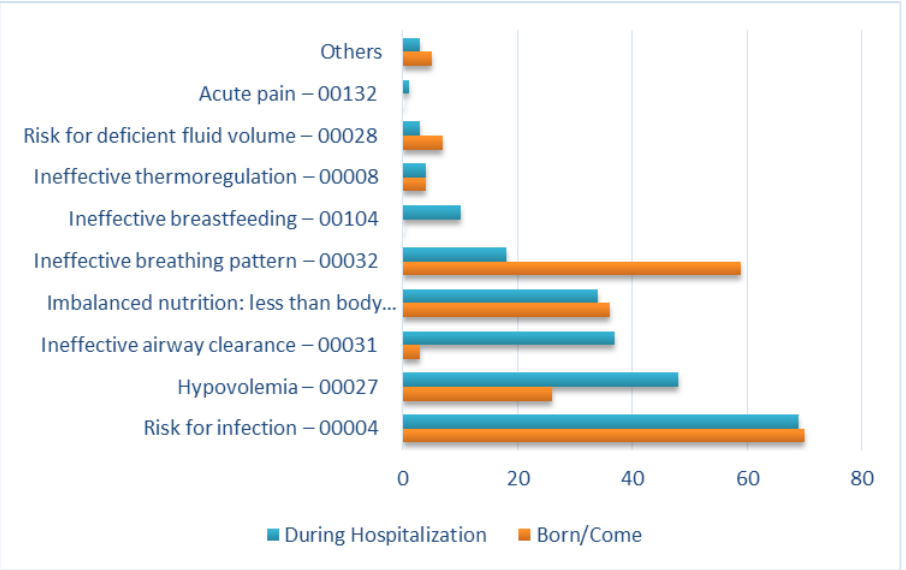
Figure 3. Nursing Diagnosis at Birth and During